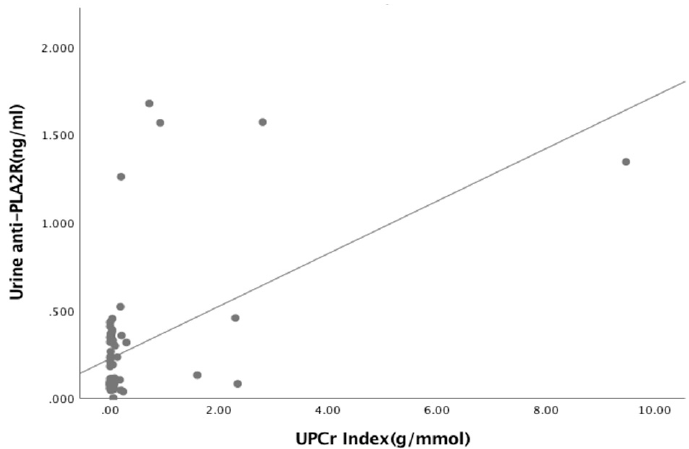
Figure A5. Relationship between Urine anti-PLA 2 R and UPCr Index (R = 437, p< 0.001).